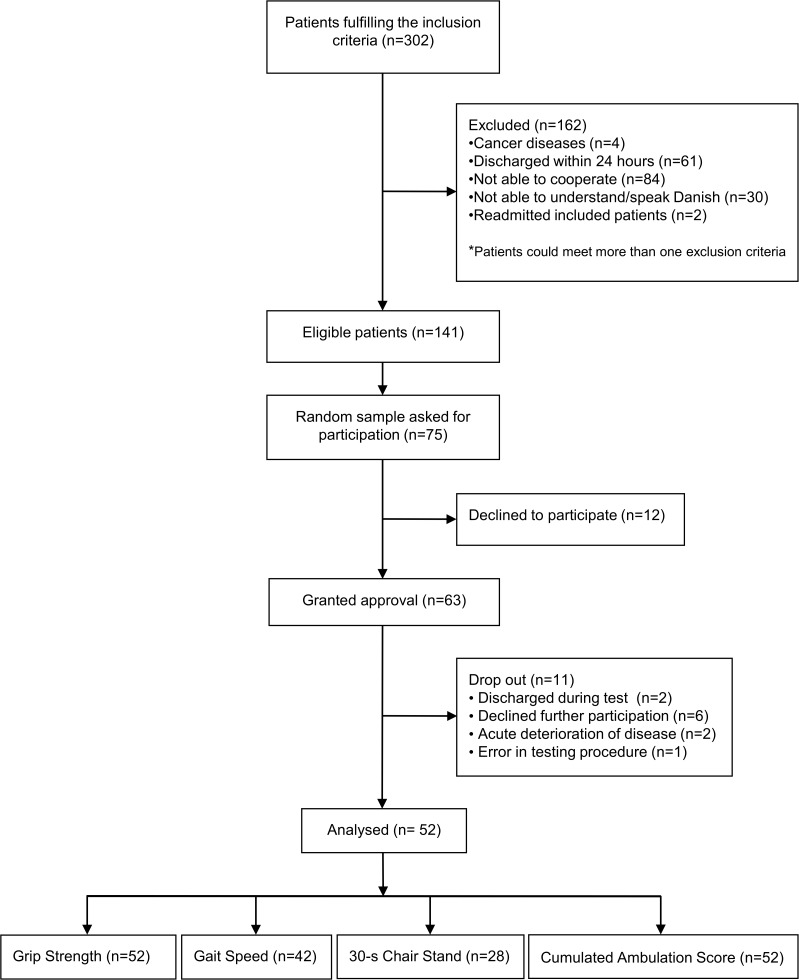
Inclusion of patients in the study (N = 52).